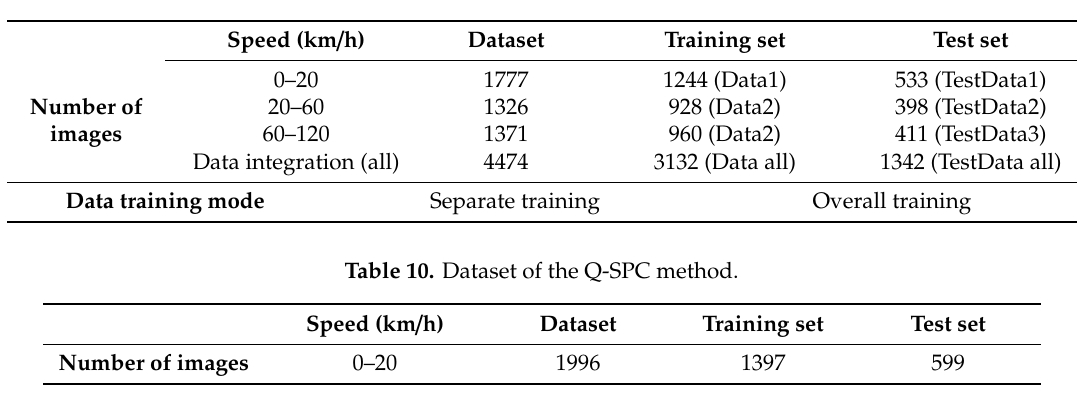
Table 9. Datasets of the SCRA method.